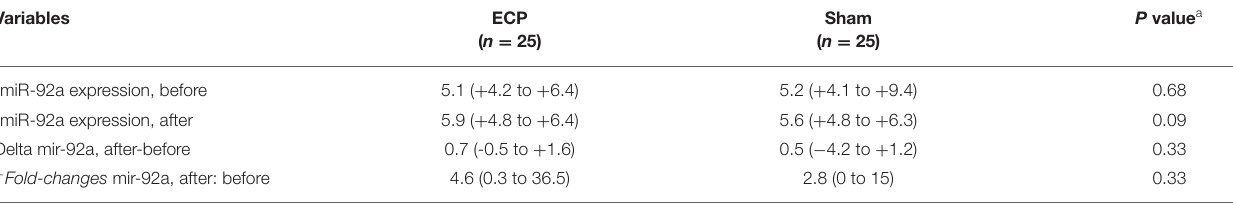
P value a Sham ( n = 25)